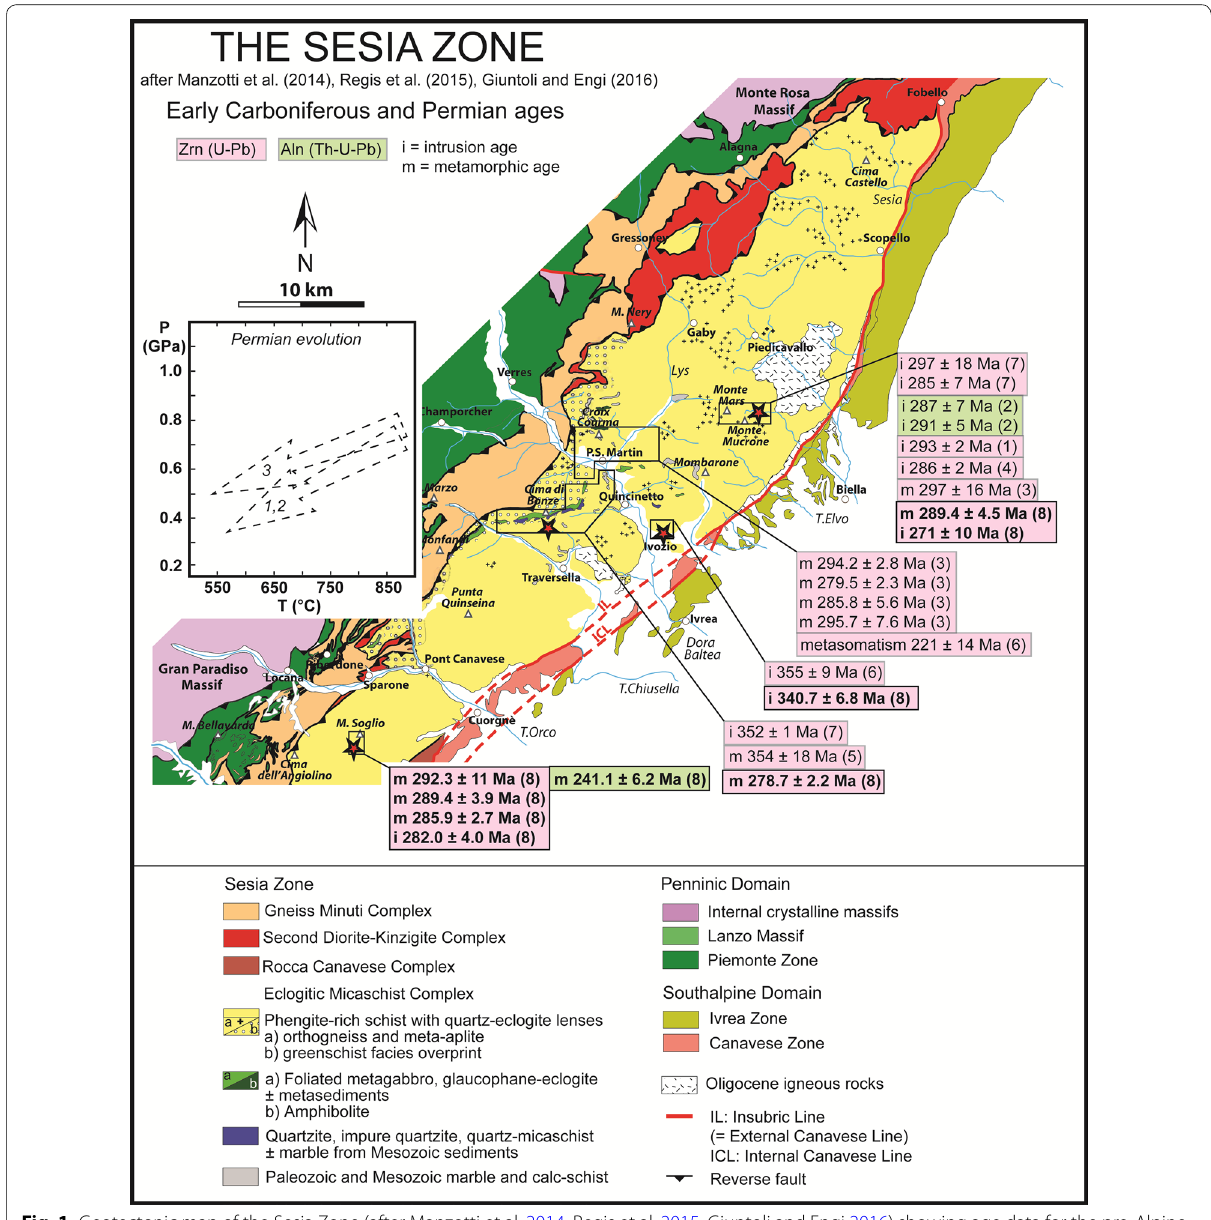
Fig. 1 Geotectonic map of the Sesia Zone (after Manzotti et al. 2014; Regis et al. 2015; Giuntoli and Engi 2016) showing age data for the pre-Alpine metamorphism in the Eclogitic Micaschist Complex. Age data are from: (1) Bussy et al. (1998); (2) Cenki-Tok et al. (2011); (3) Kunz et al. (2018); (4) Paquette et al. (1989); (5) Regis et al. (2014); (6) Rubatto (1998); (7) Rubatto et al. (1999) and (8) this study. P–T paths for the EMC are from: (1) Lardeaux and Spalla (1991); (2) Rebay and Spalla (2001); (3) Giuntoli et al.